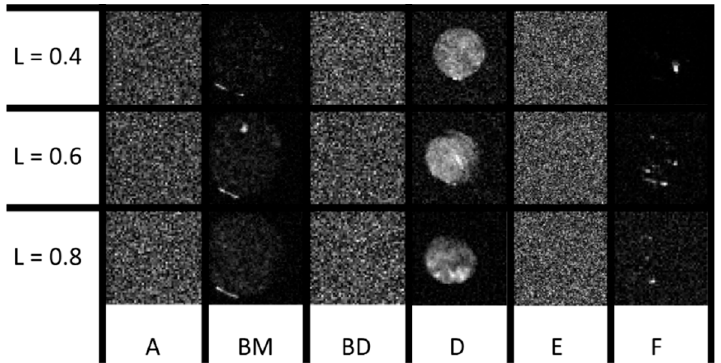
Figure 7. MR images of each core plug obtained by the RAREst sequence at high-field strength, B 0 = 4.70 T. Three axial slices are chosen to represent the length of each core.